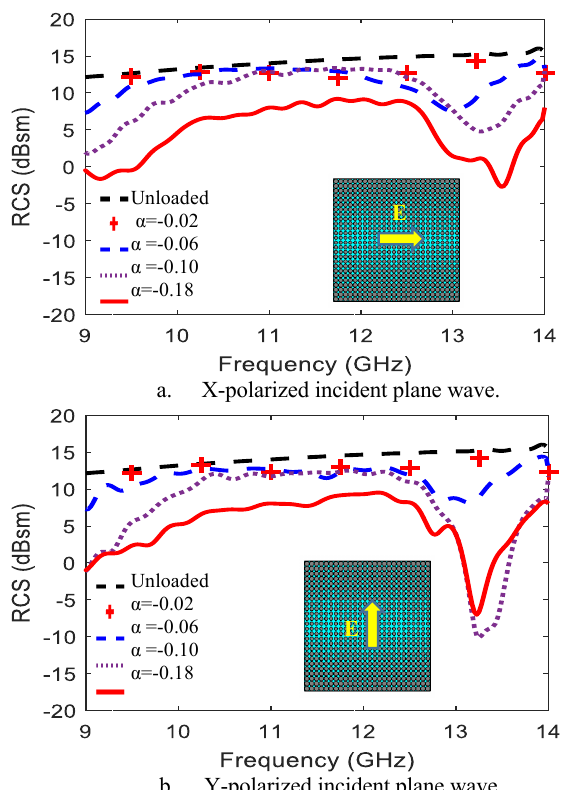
Fig. 7. The RCS response for tapered holes from the central row-in one directions with different scaling coefficient, α R o = 2.64 mm, and ζ =1